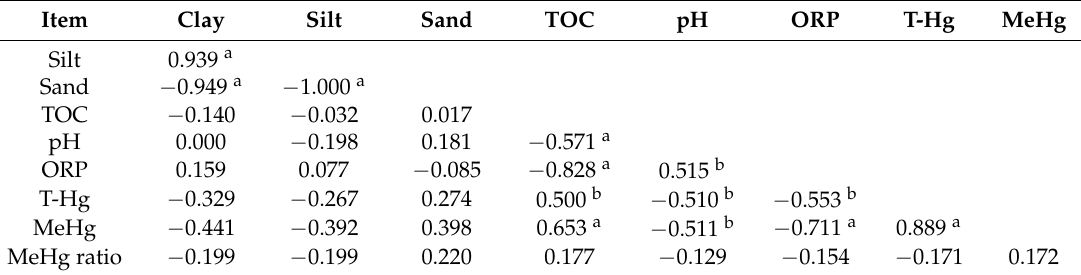
Table 5. Pearson correlation matrix for the characteristics, T-Hg, MeHg, and MeHg ratio in the sediments of Kaohsiung